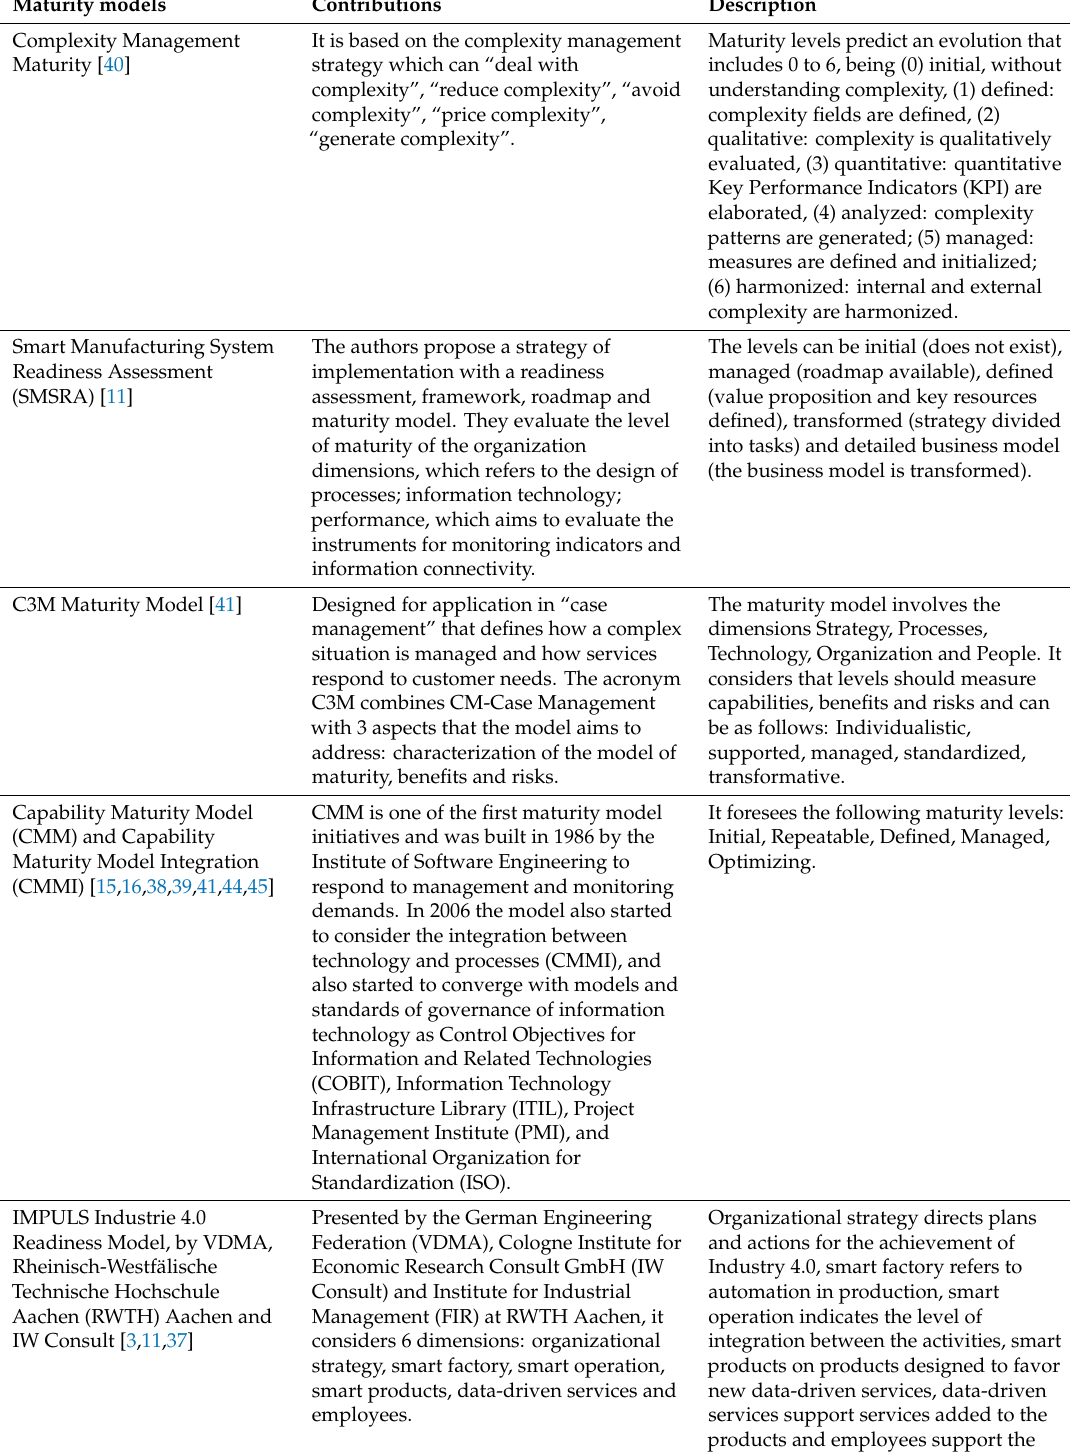
Table 3. Generic maturity models identified in the researched